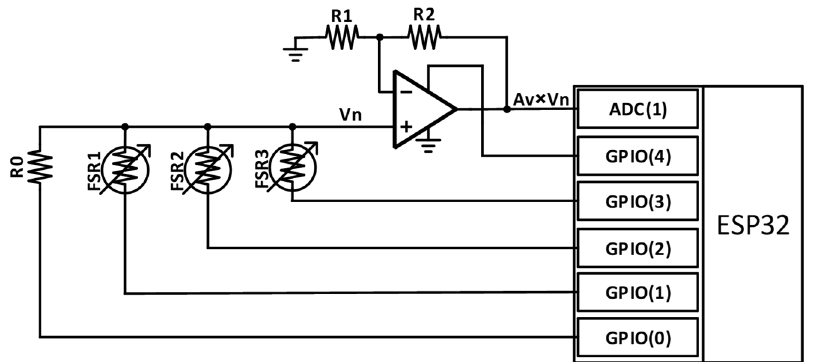
Figure 4. Flowchart of the measurement process in the proposed design.